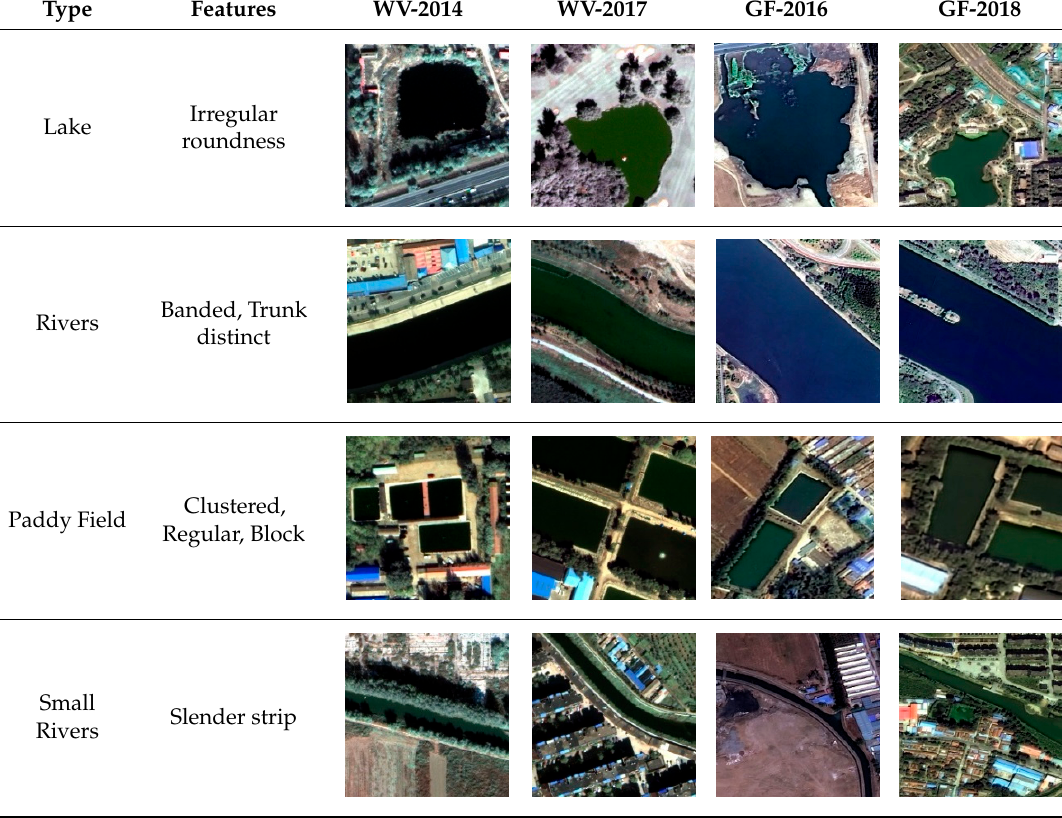
Table 1. Water Body Morphological Characteristics and Remote Sensing Image Examples.